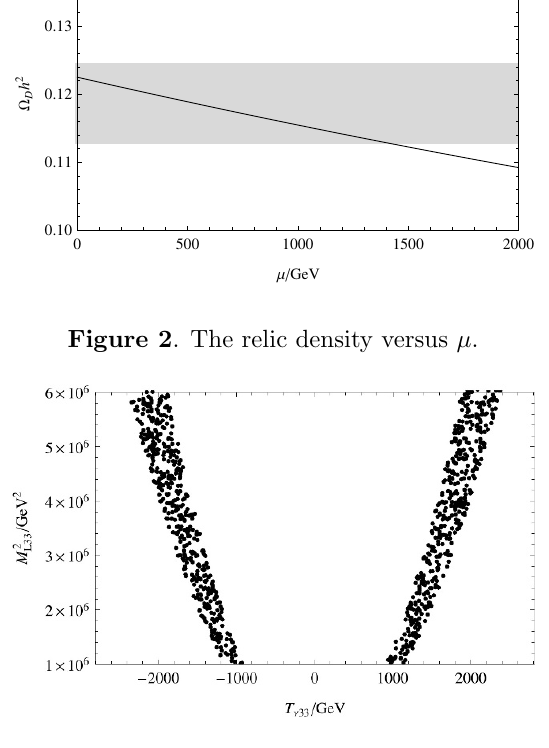
and T (cid:23) 33 L 33